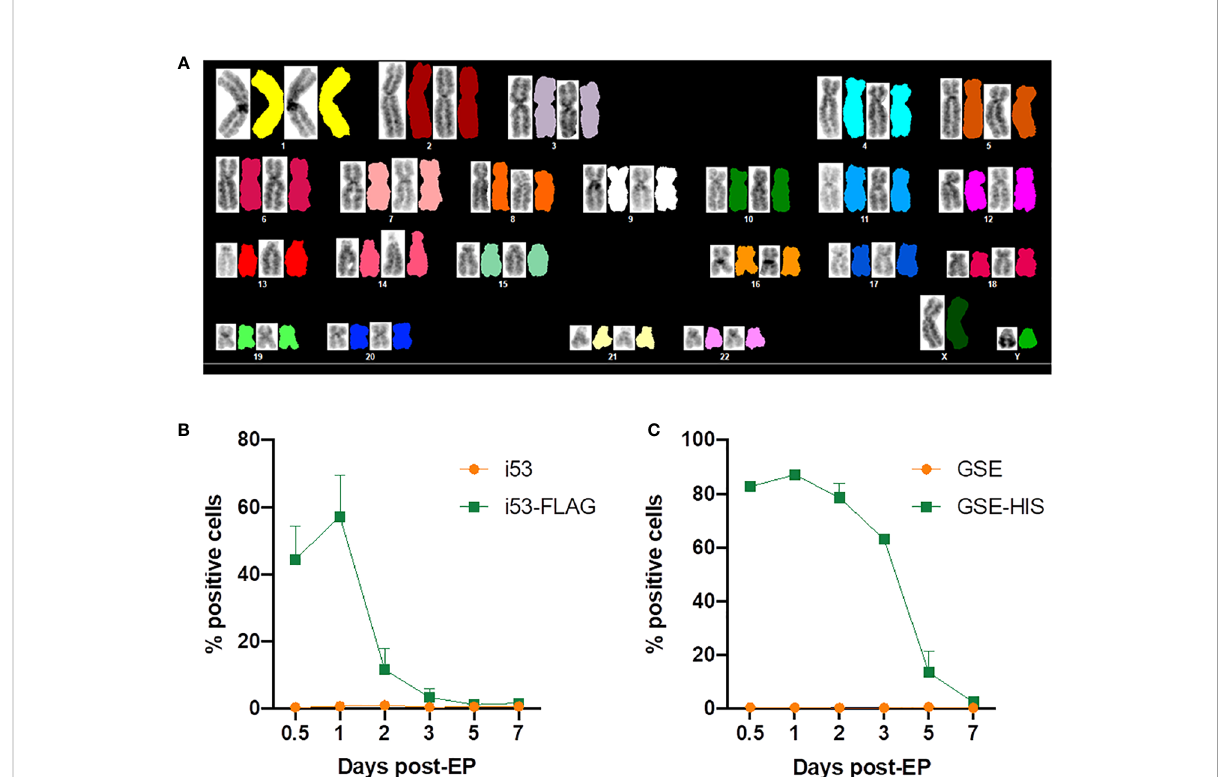
FIGURE 6 Evaluation of genomic integrity and persistence of gene editing enhancers. (A) Representative spectral karyotype image (12 metaphases imaged) of GE XSCID HSPCs analyzed using HiSKY. (B) Percentage of cells expressing i53 protein detected using an antibody directed against the FLAG tag and measured by fl ow cytometry at the indicated days post-electroporation (EP) (n = 2 independent experiments). (C) Percentage of cells expressing GSE CS-56 protein detected using an antibody directed against the HIS tag and measured by fl ow cytometry at the indicated days post-EP (n = 2 independent